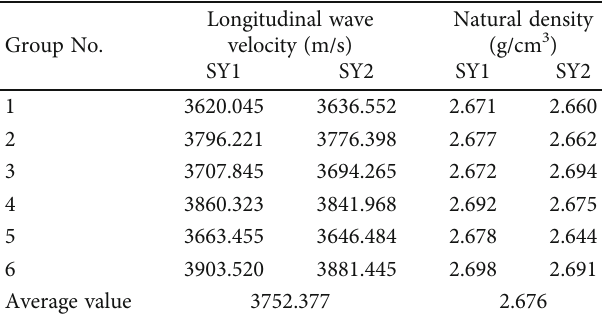
Table 1: Longitudinal wave velocity and natural density of specimens. Group